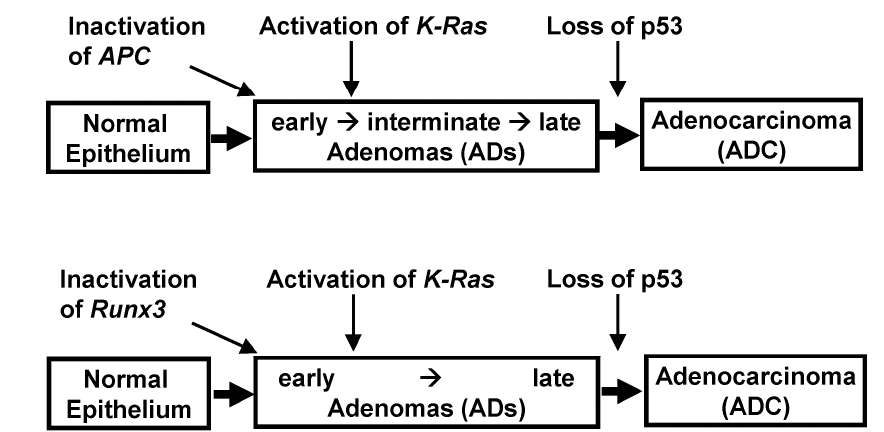
Figure 3. Sequential molecular events occurring during multistep tumor progression. Most colorectal and lung adenocarcinomas develop through a multistep tumorigenesis pathway. Tumors show development from normal tissue, to adenoma (AD), to adenocarcinoma (ADC), and ultimately progress to multiple types of invasive tumors. Molecular events occurring at each step are